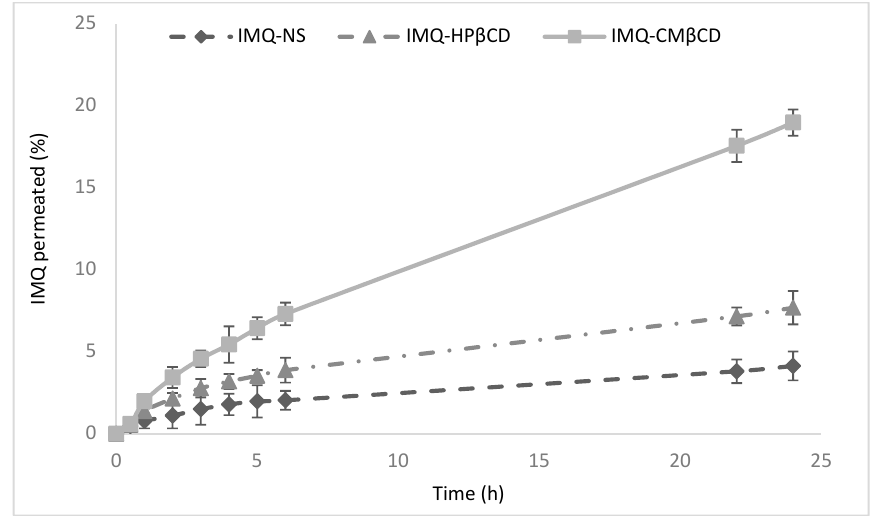
Figure 5. In vitro permeation profiles of IMQ-loaded NS and IMQ complexes through pig skin.